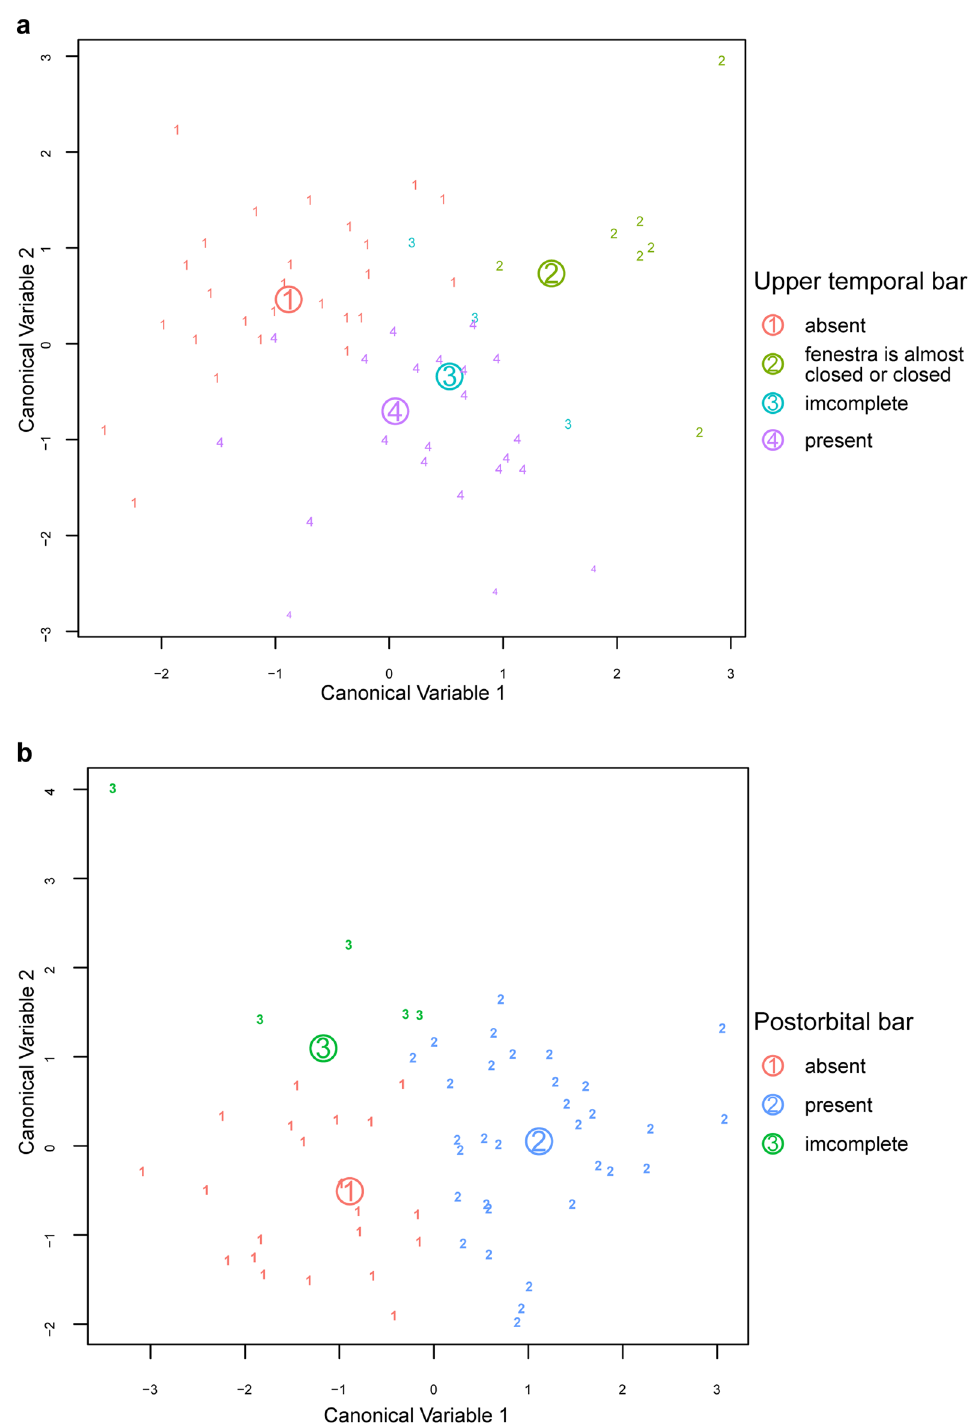
Figure 3. Results of flexible discriminant analysis (FDA). ( a ) On the presence of the upper temporal bar. ( b ) On the presence of the postorbital